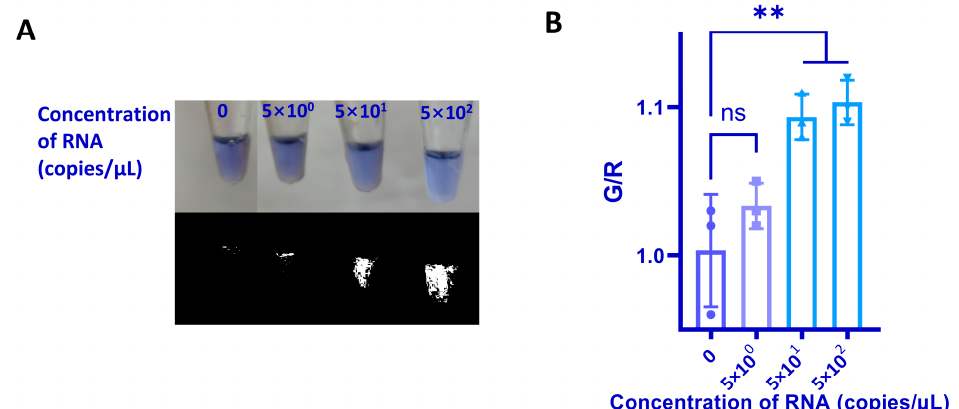
Figure 4. Sensitivity evaluation of the self ‐ testing system. ( A ) Visual outcome of a 10 times dilution of SARS ‐ CoV ‐ 2 RNA positive control ranging from 500 to 5 copies/ μ L. The top image is the original image taken with a cellphone. The bottom image is the binary image after G/R processing. ( B ) G/R ratio of the RT ‐ LAMP reaction with different concentrations of SARS ‐ CoV ‐ 2 RNA. G/R ratio of each concentration was calculated from three parallel tests and represent the mean value of the three tests. The statistical analyses were performed using a one ‐ way analysis of variance, where ns = not significant with p > 0.05, and the ** denotes significant differences with p values between 0.0001 to 0.001.